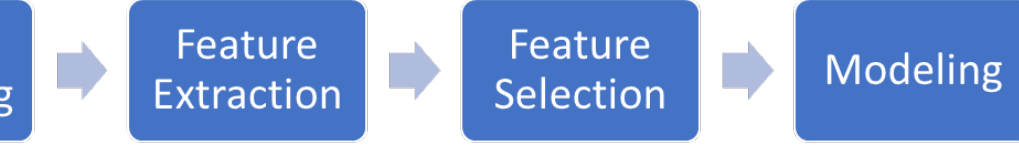
Figure 1. Workflow of gait analysis with machine learning.